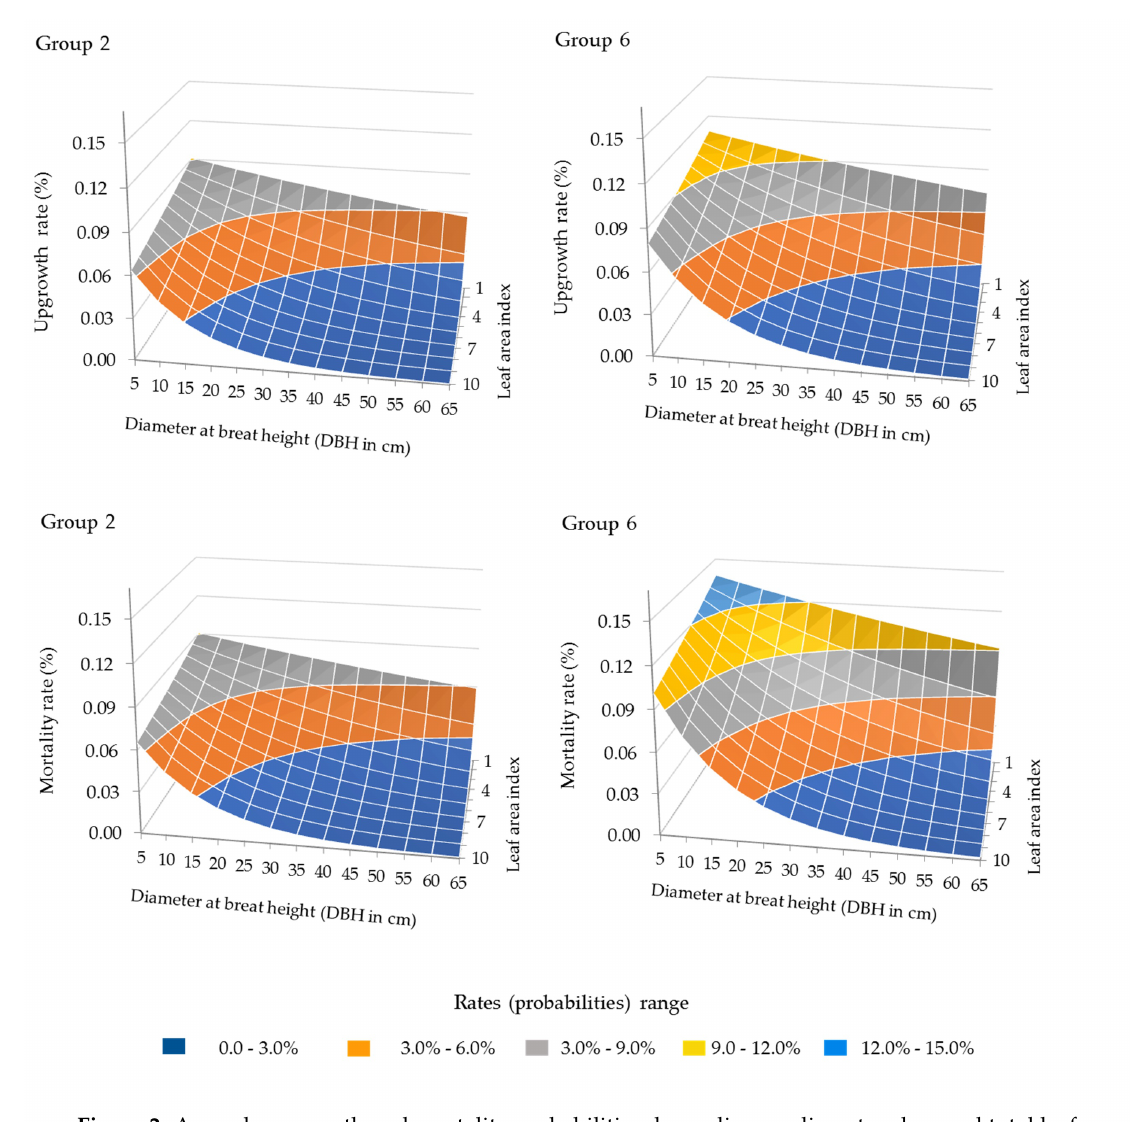
Figure 2. Annual up-growth and mortality probabilities depending on diameter class and total leaf area